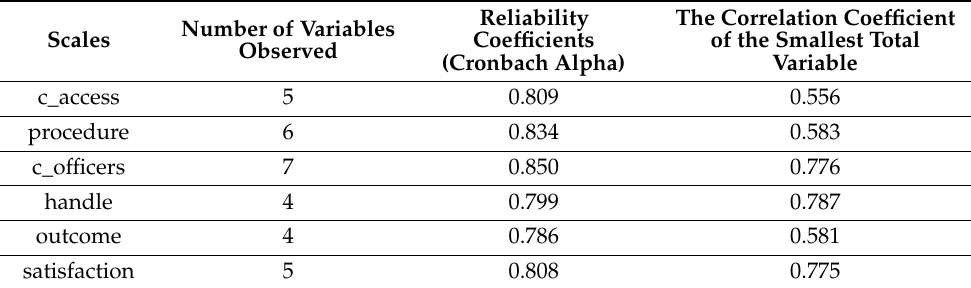
Table 2. Summary of reliability and relative minimum variables of scales.